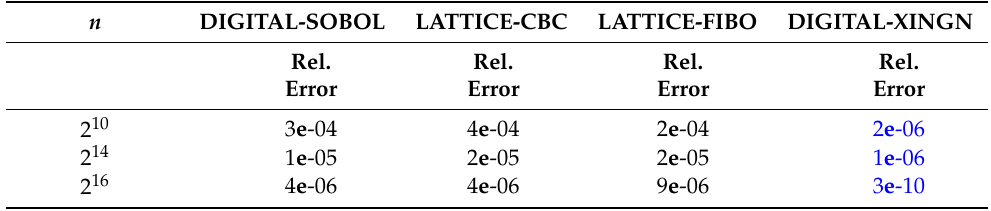
Table 1. RE for AE of f 0 ≈ 0.048.